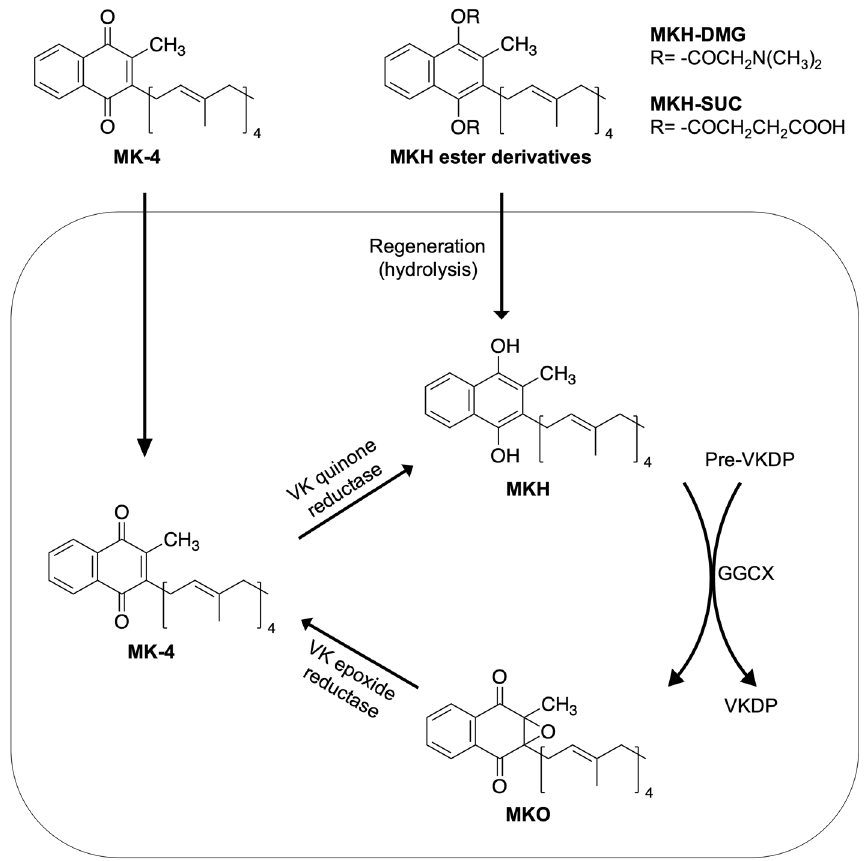
Figure 2. Schematic illustration of the vitamin K cycle and concept of the menahydroquinone-4 delivery system. MKH, menahydroquinone-4; MK-4, menaquinone-4; MKO, menaquinone-4 epoxide; VK, vitamin K; VKDP, vitamin K-dependent protein; GGCX, γ-glutamyl carboxylase.